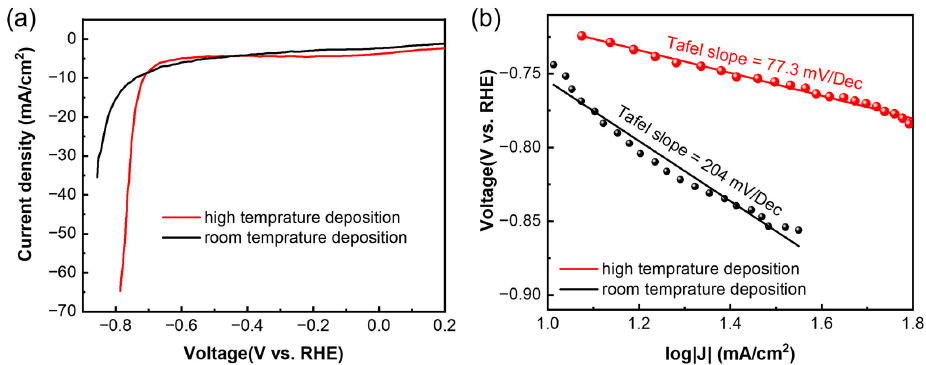
Figure 5. ( a ) Linear sweep voltammetry test of Sb nanofilms deposited at different temperatures, and ( b ) corresponding Tafel slopes.